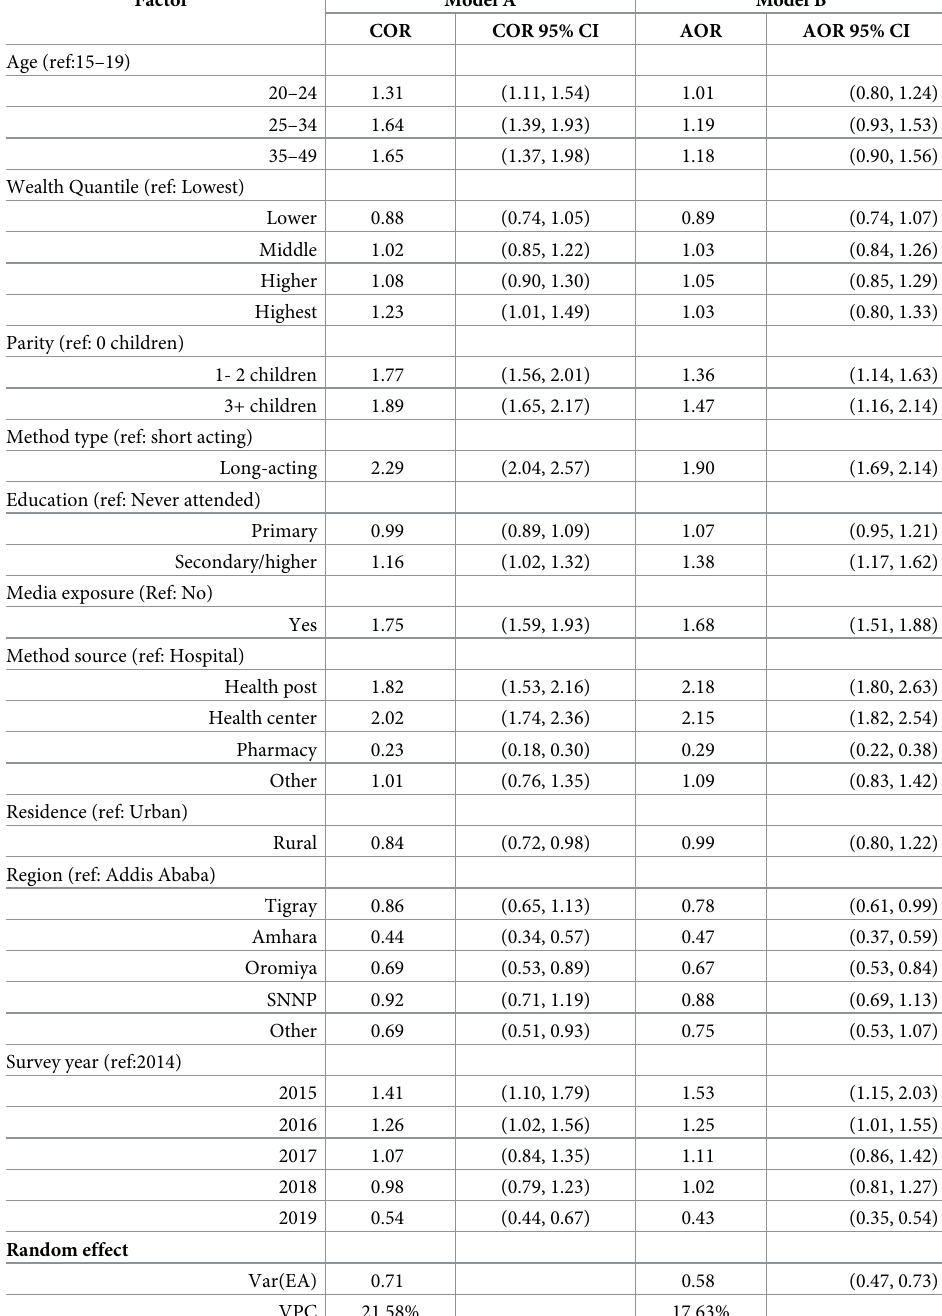
Table 4. Parameter estimates from the multilevel ordinal logistic regression model of receiving high quality family planning counseling service in